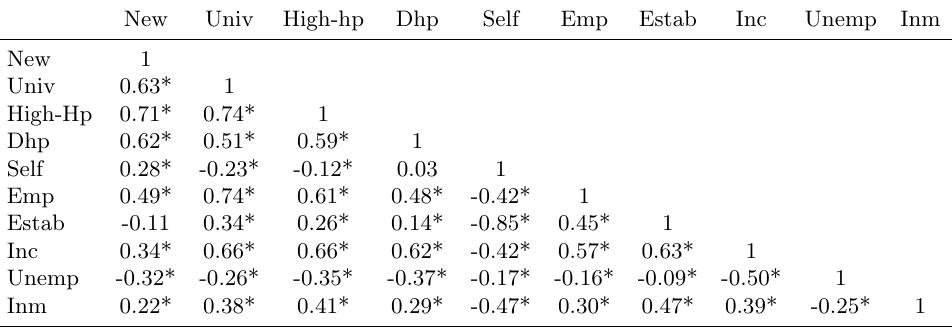
Table 2: Correlation